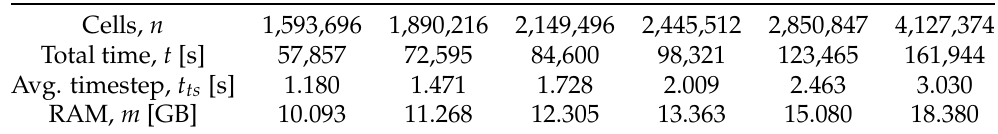
Table A9. AMR generated grids when using the k − ω SST model. Refinement frequency is set to 1000 timesteps. Load balancing is disabled. AMR specifics are defined in the manuscript. Presented values are three-run averages. A total of 48 cores are used for all